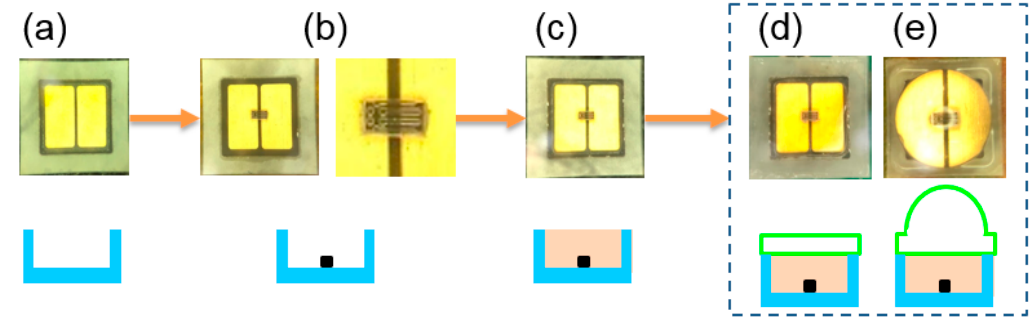
Figure 4. Packaging process of the liquid-package PT-IV and PT-V DUV-LEDs.